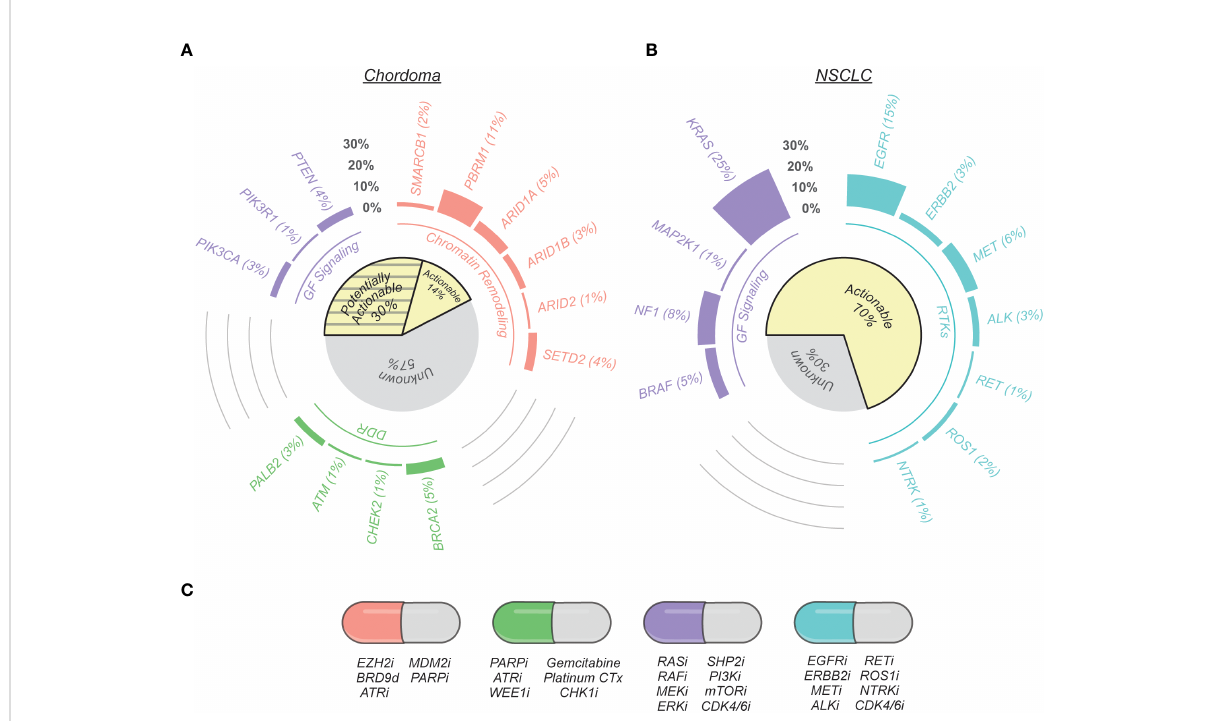
FIGURE 1 Therapeutically relevant genomic alterations found in chordoma and non-small cell lung cancer (NSCLC). (A) Nonsynonymous mutation call data from chordoma tumors were compiled from seven published genomic pro fi ling studies (20 – 26). Genes are grouped by their protein functionality (chromatin remodeling, DNA damage repair (DDR), growth factor (GF) signaling, and receptor tyrosine kinases (RTKs)) and were selected by on their association with potential therapeutic opportunities based on current scienti fi c literature, as reviewed here. The cohort of tumors analyzed for potentially targetable alterations varied on a per gene basis to account for variation between sequencing techniques and data presentation across studies: SMARCB1 (n = 2 altered/123 total), PBRM1 (22/203), ARID1A (6/123), ARID1B (3/104), ARID2 (2/203), SETD2 (8/ 203), PTEN (8/179), PIK3CA (6/203), PIK3R1 (1/123), BRCA2 (12/260), CHEK2 (1/123), ATM (1/123), PALB2 (7/260). The subset of actionable gene alterations are existing standard care or investigational biomarkers predictive of response to an FDA-approved or investigational drug in